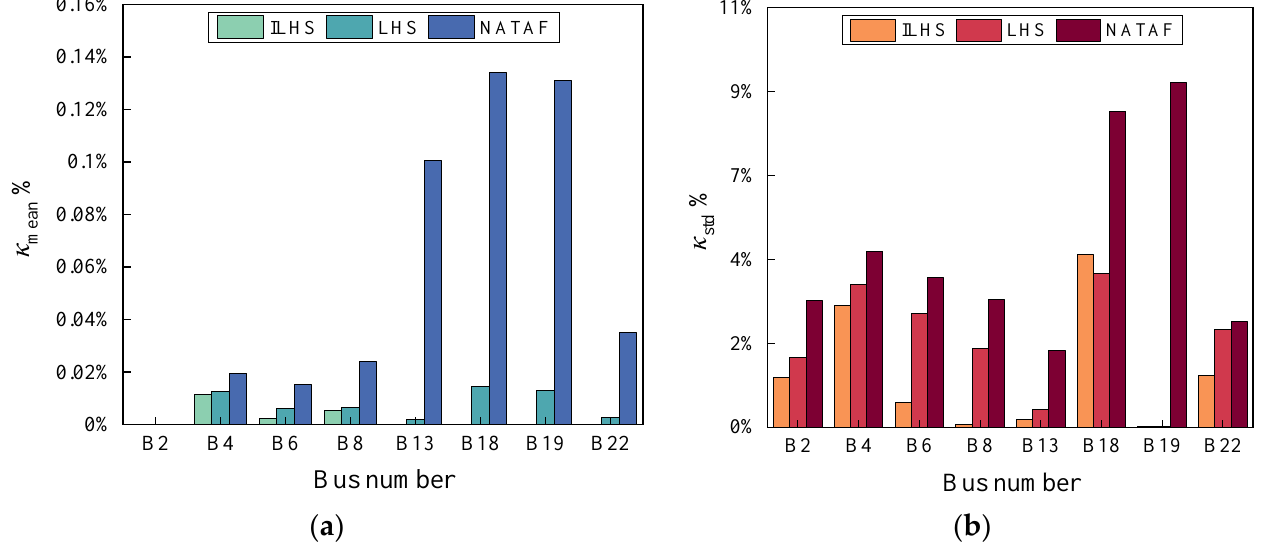
Figure 7. Comparison of ( a ) the mean error and ( b ) the standard deviation error of the AC bus voltage magnitudes.